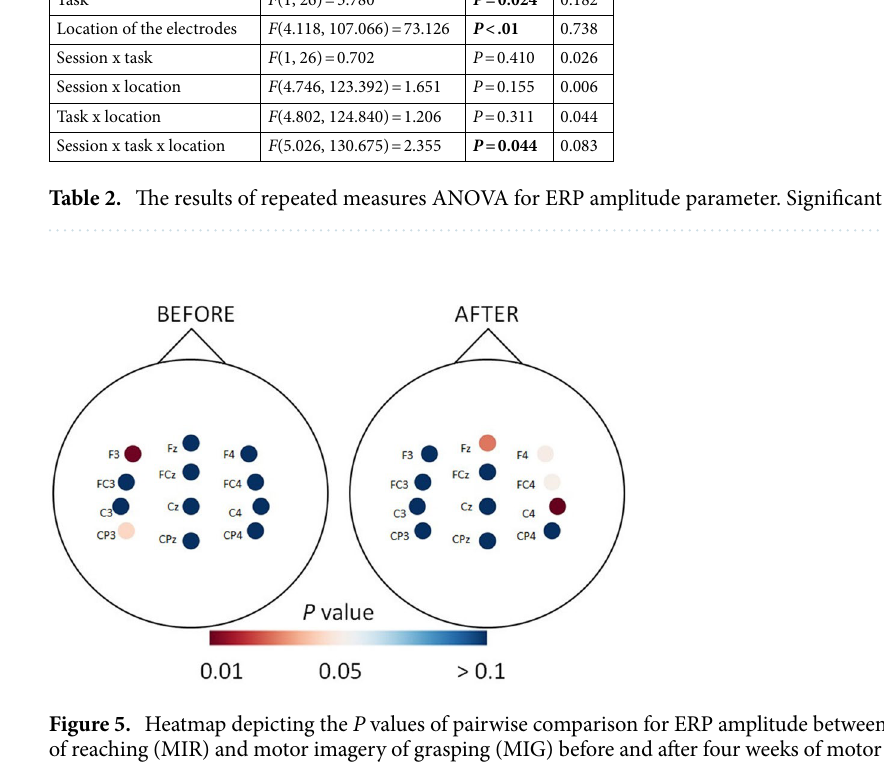
ERP amplitude for different electrode locations. We dropped the comparison of all electrodes in favor of func- tionally meaningful comparisons. This solution reduced the number of comparisons from 66 to 8. Therefore, four pairwise comparisons were performed between electrodes above the left and right hemispheres: F3 vs. F4, FC3 vs. FC4, C3 vs. C4, and CP3 vs. CP4 (left to right; shaded area in Table 3). Also, four pairwise comparisons were performed between electrodes located above the premotor cortex and the sensorimotor cortex of the same hemisphere: F3 vs. C3, FC3 vs. CP3, F4 vs. C4, and FC4 vs. CP4 (top-to-bottom; Fig. 6). The result shows that for the left to right comparisons, there were no significant differences ( P > 0.05) between electrodes for both tasks and sessions, except for the higher ERP amplitude for CP4 compared to CP3 for MIG during the session before training ( P = 0.012; Table 3). However, for the top-to-bottom analysis, all the electrodes located above the premotor cortices had significantly ( P < 0.05) higher ERP amplitudes than the electrodes above the sensorimotor cortices for both tasks and sessions, except FC4 vs. CP4 for MIG and the session after training (Table 3). ERP amplitude before and after MIT. The ERP amplitude significantly increased after training for the two centrally located electrodes for the MIR task (FCz, t (26) = 2.97, P = 0.006, d = 0.06; Cz, t(26) = 2.31, P = 0.029,